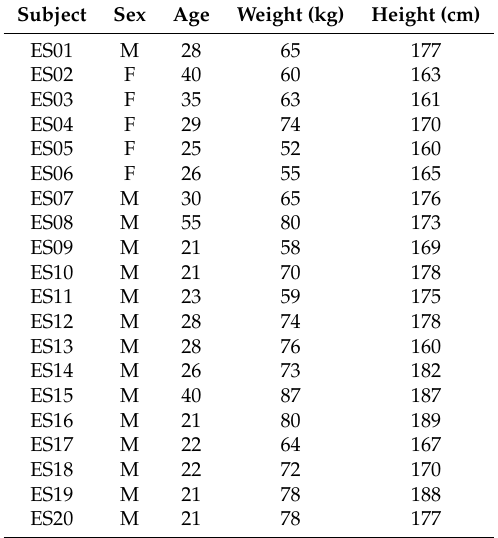
Table 2. Dataset of the subjects participating in the